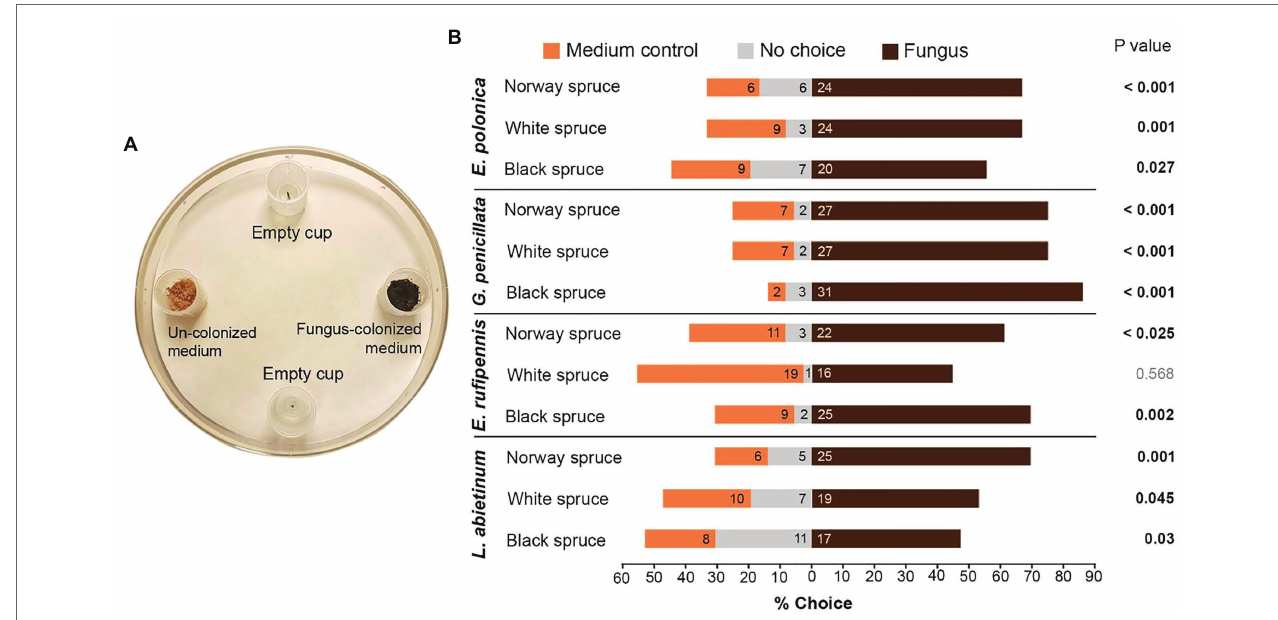
FIGURE 3 | (A) Trap bioassays to test attraction of I. typographus toward traps baited with fungus-colonized spruce bark medium (Fungus) or un-colonized medium (Medium control). Empty traps served as a negative control. Two beetles were released into each test arena. (B) The percentage of beetles that entered the different traps or remained in the test arena (numbers inside the bars show actual beetle numbers). p values indicate the outcome of Wilcoxon signed-rank tests comparing fungus and medium control for each combination of spruce species and fungal species ( n = 18; two independent tests using nine individual trees per spruce species). E, Endoconidiophora ; G, Grosmannia ; and L, Leptographium